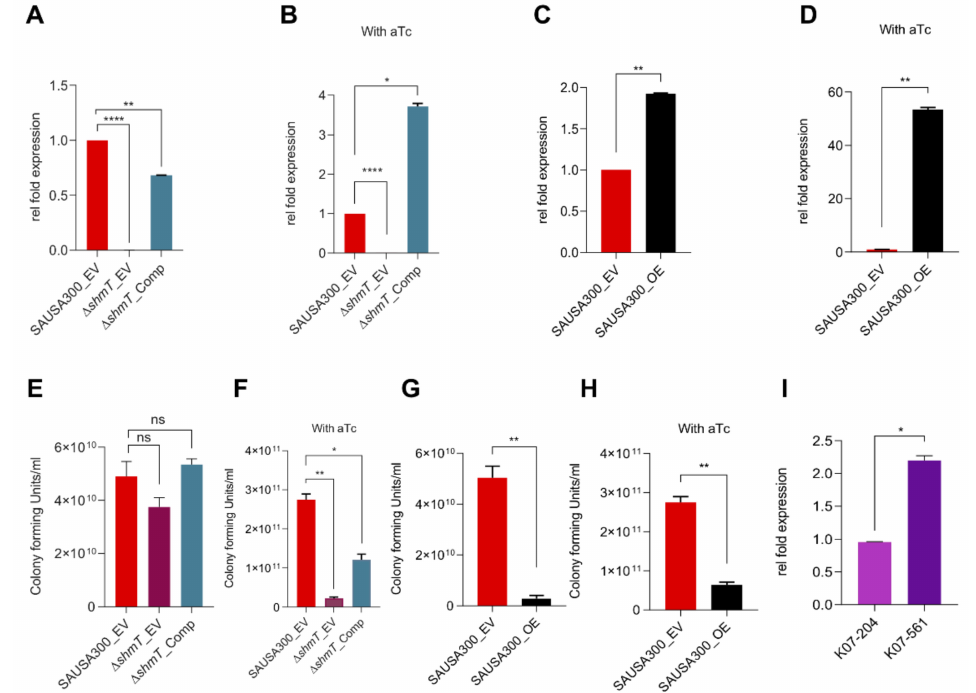
Figure 5. than control. ( E – F ) Assessment of colony forming unit in SAUSA300 recombinant